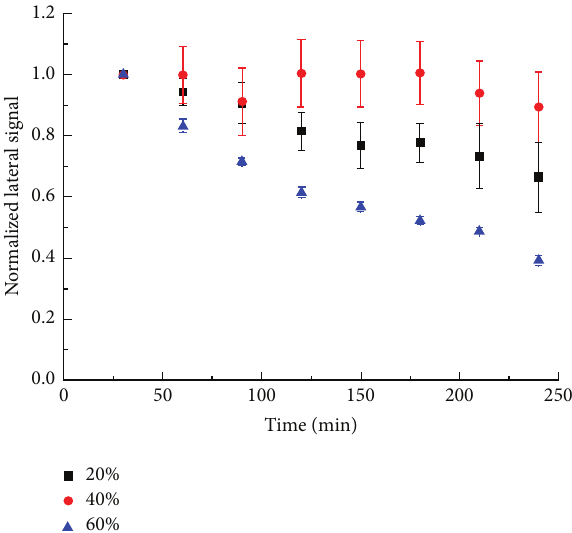
Figure 1: Normalized lateral force signal of ODT at different relative humidity conditions.